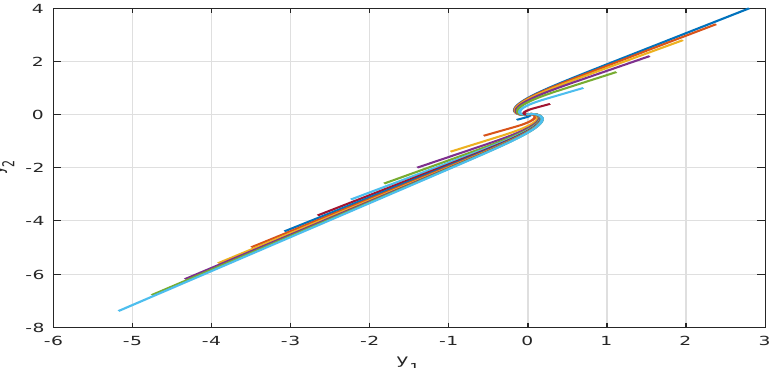
Figure 13. An illustration of the time responses between the imaginary subspace pertaining to the model in (20), in which ˜ u ( t ) = 0 in Example